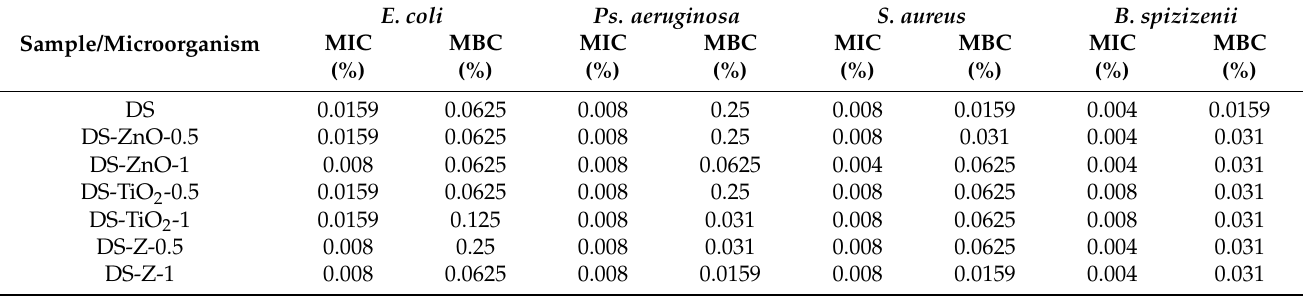
Table 4. Minimal inhibitory concentration (MIC) and minimal bactericidal concentration (MBC)